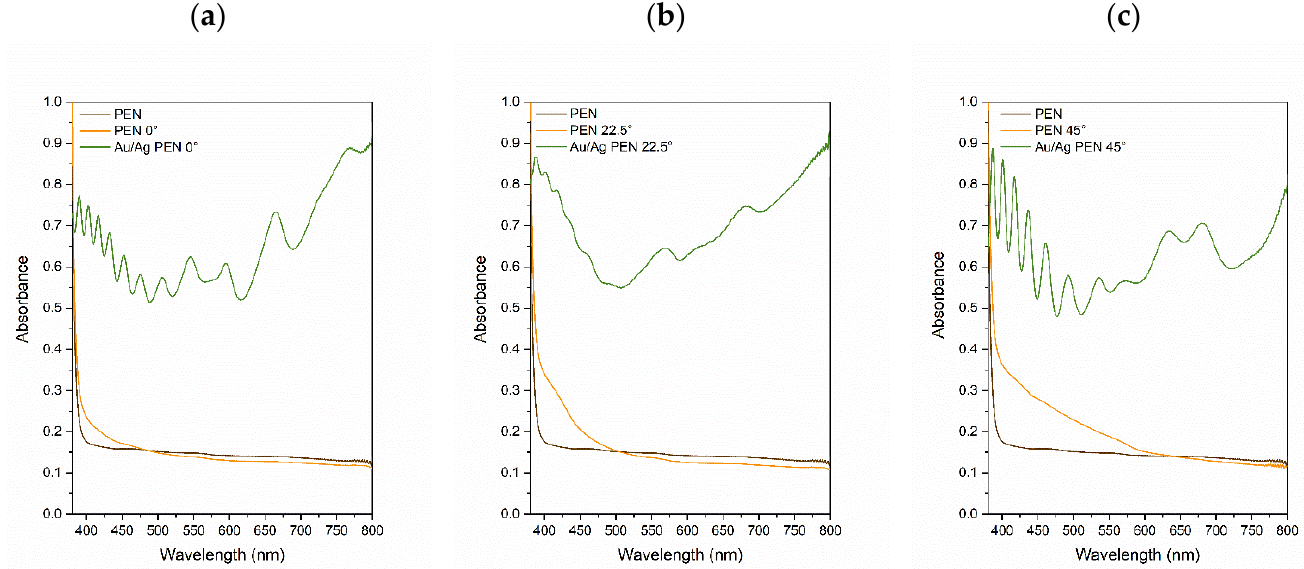
Figure 6. UV-Vis spectra of PEN, modified PEN and PEN with Au/AgNWs at incidence angles of ( a ) 0°, ( b ) 22.5° and ( c ) 45°.